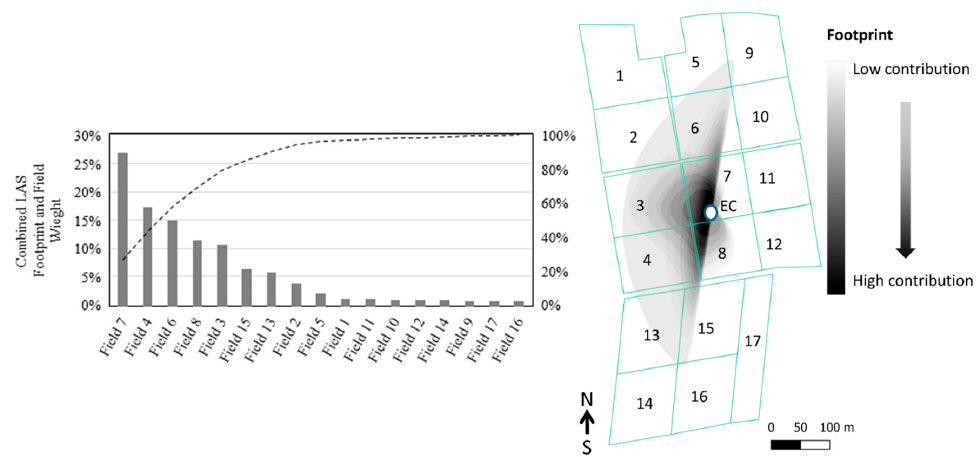
Figure 12. The vineyard fields and the dominant LAS and EC footprints ( left ), and the weighted contribution of the vineyard fields on LAS and EC observations ( right